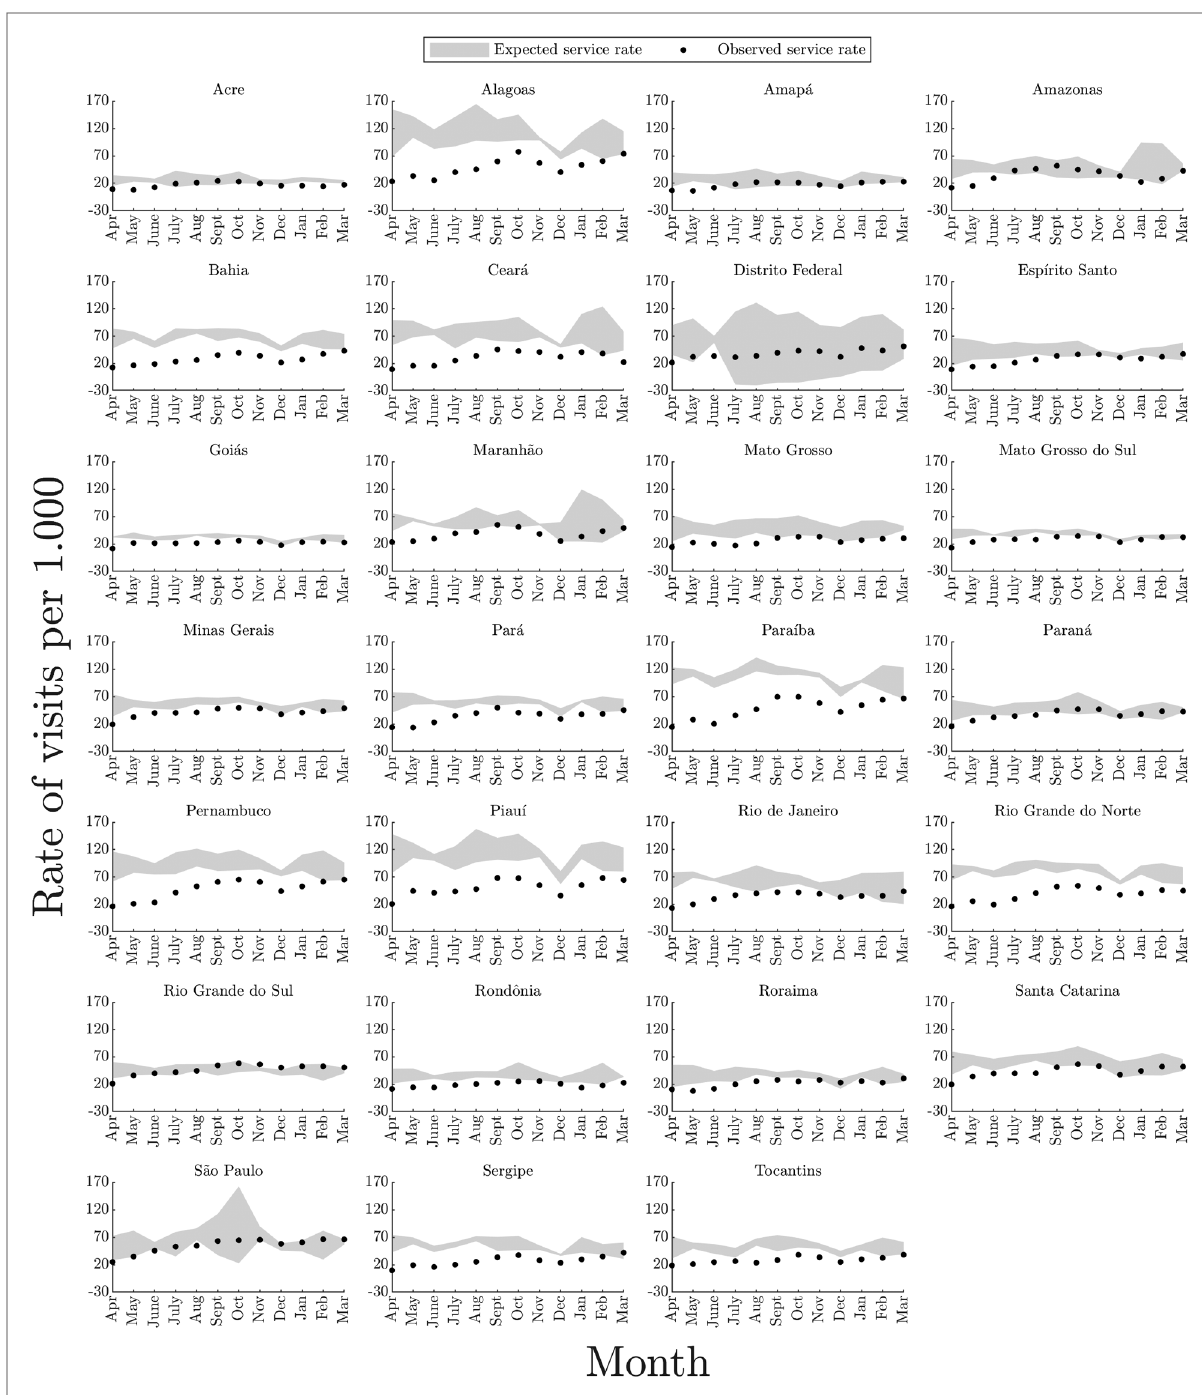
FIGURE 2 Monthly rates of visits performed in primary health care services, per thousand children up to fi ve years of age, to monitor the growth and development of children, according to states and the Federal District in Brazil. In gray: expected rates – pre-pandemic period (from April 2017